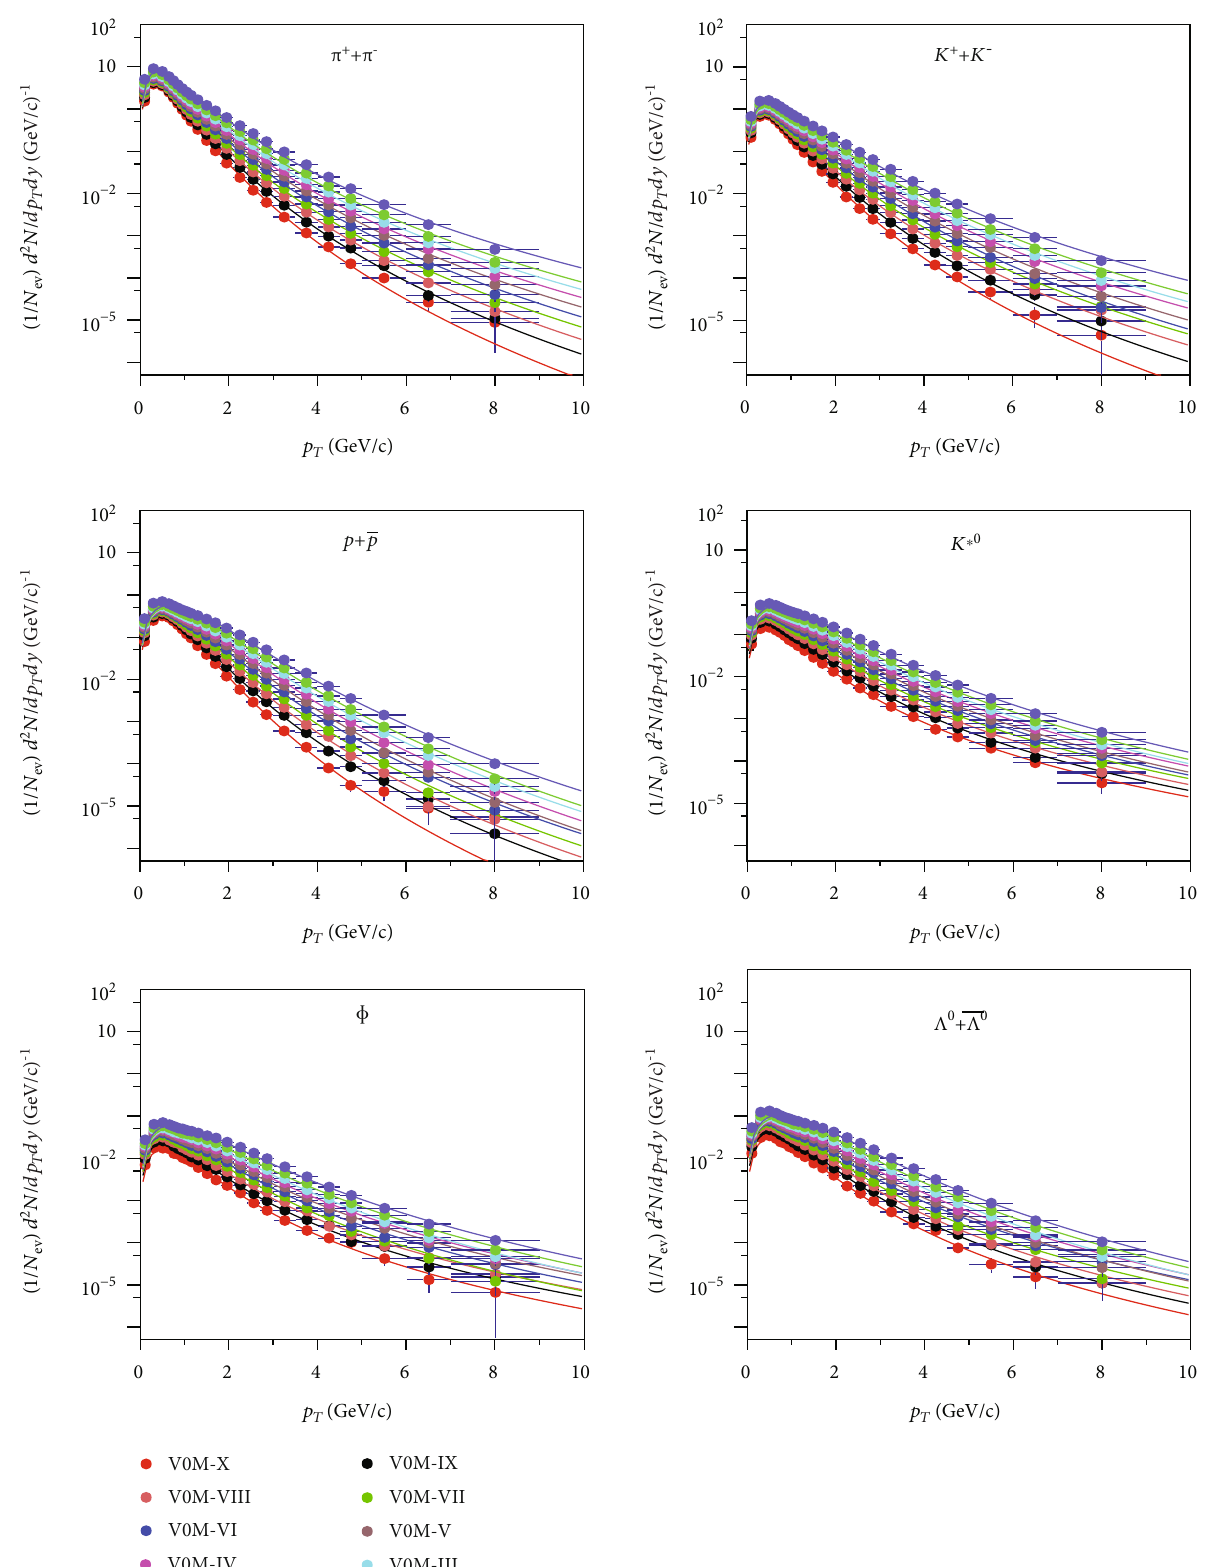
Figure 5: (Color online) Fitting of generated p -spectra of identi fi ed hadrons from PYTHIA8 using Tsallis distribution for isotropic events in T various multiplicity classes as shown in Table